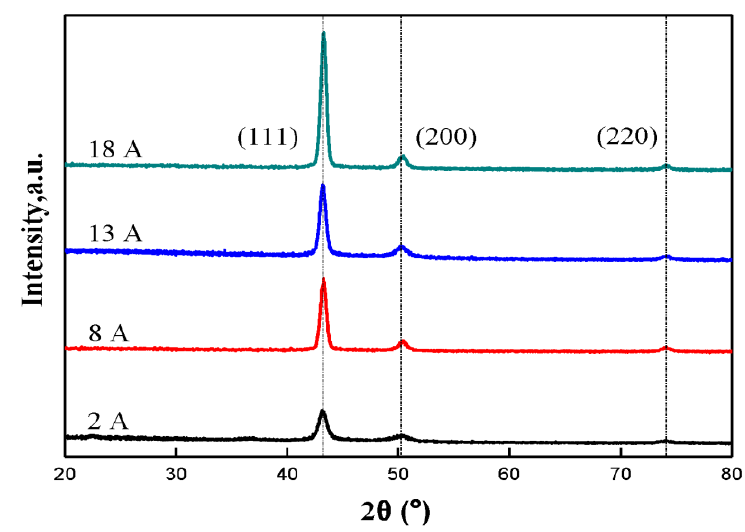
Figure 6. XRD pattern of the Cu